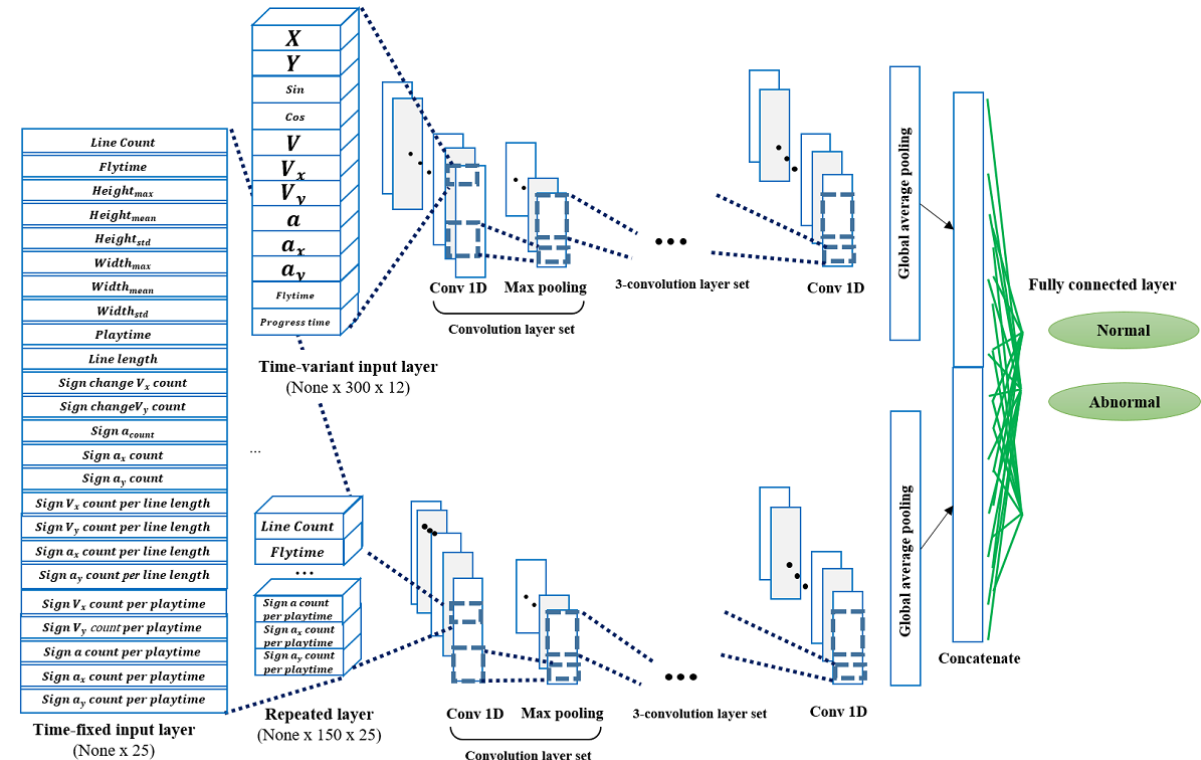
Figure 2. Deep learning model architecture. conv: